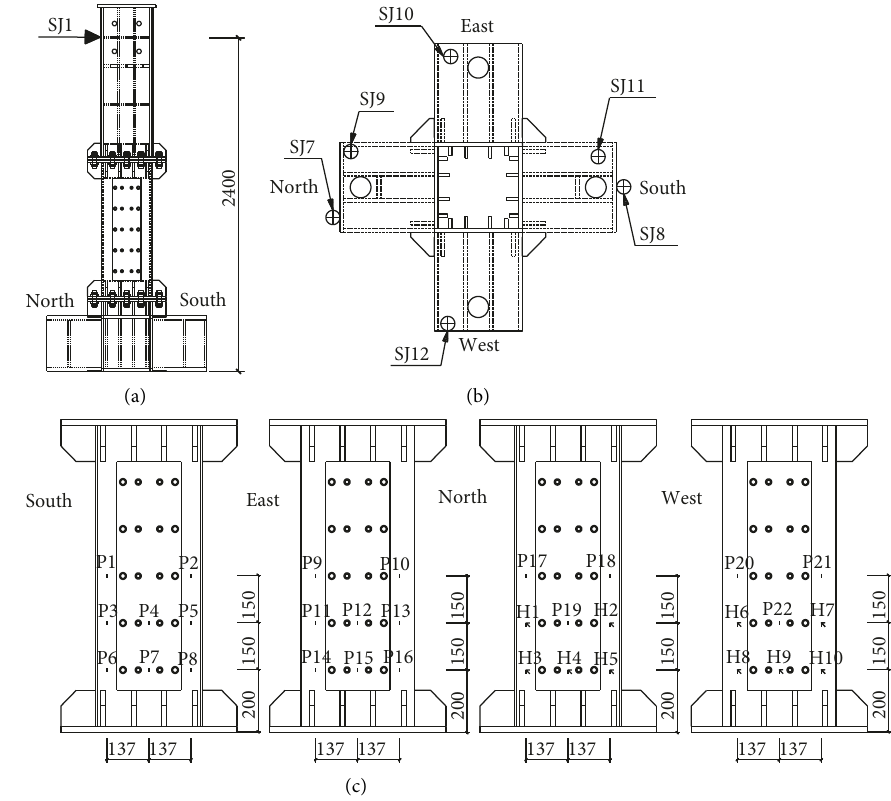
Figure 5: Measurements for the specimens. (a) Laser measurements at the top. (b) Displacement measurements of the rigid support. (c) Strain gauges of the energy-dissipating